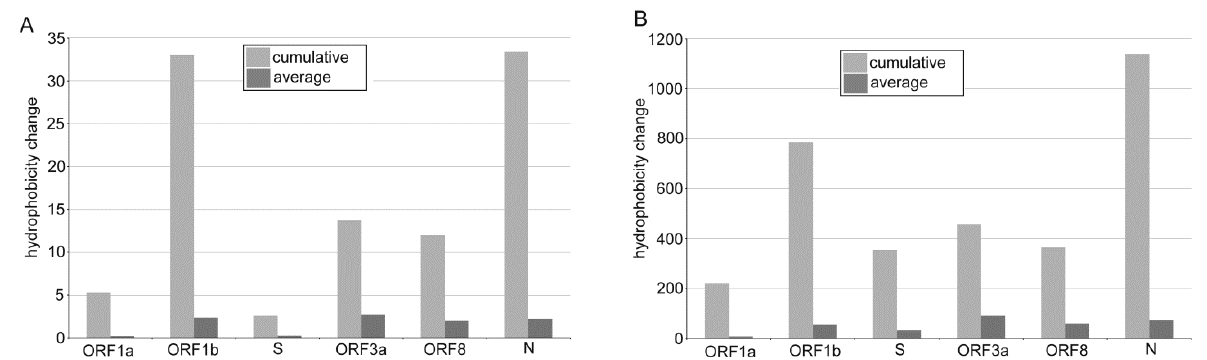
Figure 5. Shifts in amino acid hydrophobicity caused by SNVs in SARS-CoV-2 subregions. Cumulative and average values were computed using the amino acid hydrophobicity scales according to [33] ( A ) and [34] ( B ).